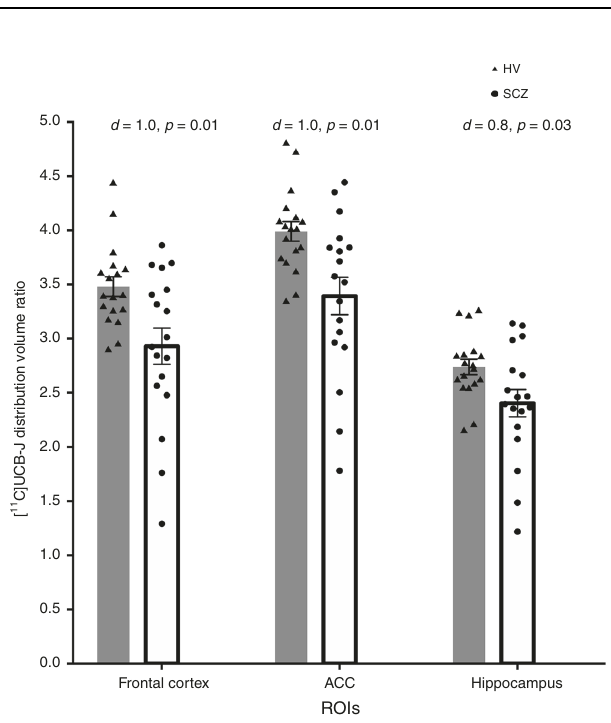
Fig. 3 Regional mean [ 11 C]UCB-J distribution volume ratio (DVR) group. Grey bars depict regional mean DVR in the healthy volunteer (HV) group, and triangles represent individual HV DVR ( n = 18). Hollow bars depict mean DVR in the schizophrenia (SCZ) group, and circles indicate individual SCZ patient DVR ( n = 18). FDR-adjusted p values from post-hoc t -tests are reported here. [ 11 C]UCB-J DVR was signi fi cantly reduced with large effect sizes (Cohen ’ s d > 0.8) in the SCZ compared to the HV group in the frontal cortex, anterior cingulate cortex (ACC) and the hippocampus. Error bars indicate standard error of the mean.